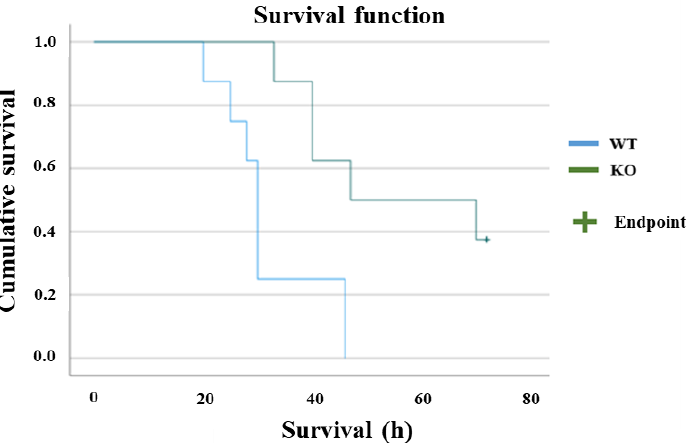
Figure 1. Sepsis-induced hypothermia. At 0 h, the mean body temperatures of the WT and KO mice were not significantly different, at 36.2 °C and 36.5 °C, respectively. However, 18 h after the CLP treatment, the body temperatures of the WT group decreased to 29.9 °C, whereas those of the KO group were maintained at 32.0 °C. Data are expressed as means ± SD, * p < 0.008, n = 10.